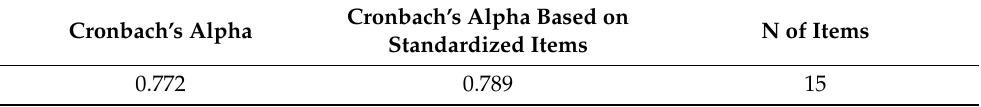
Table 5. Scale reliability.